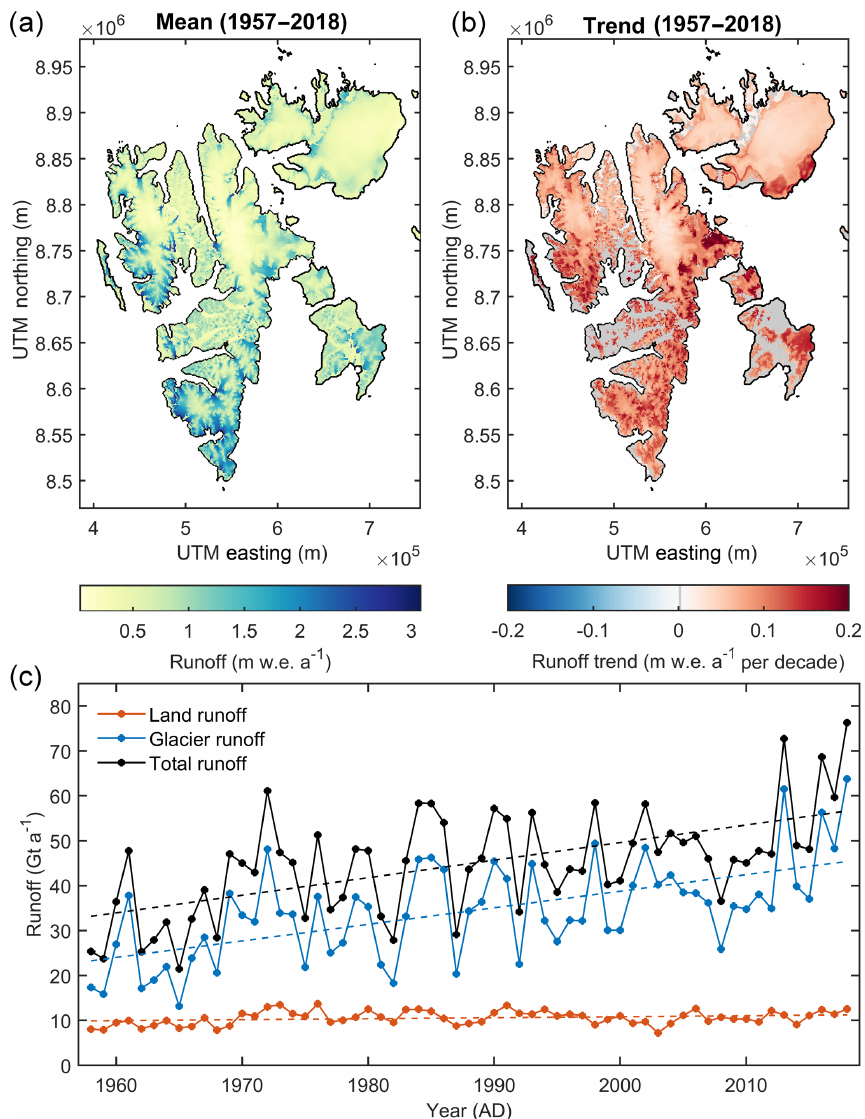
Figure 11. Long-term mean spatial runoff distribution (a) and trends (b) . In (c) time series of area-averaged annual glacier, land and total runoff (solid lines) and linear trends (dashed lines) are shown. Years in (c) are defined between 1 September (preceding year) and 31